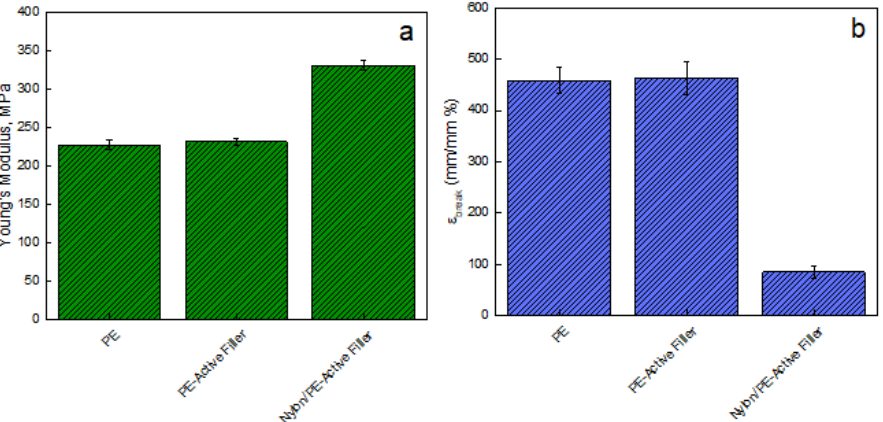
Figure 3. ( a ) Young’s Modulus (MPa) and ( b ) Elongation at break point (mm/mm%) evaluated on films of: pure PE, PE-Active Filler, and Nylon/PE-Active Filler.